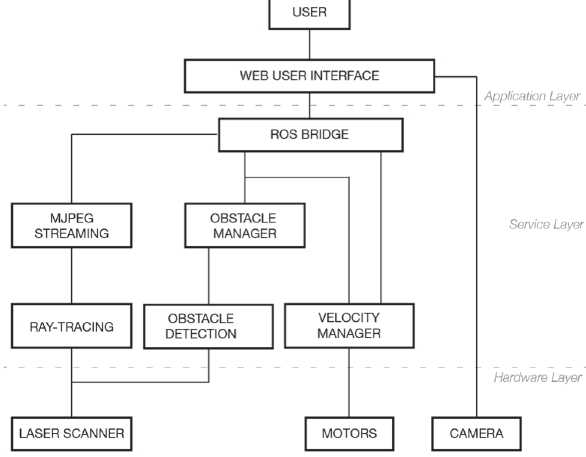
Figure 4 | Software architecture.